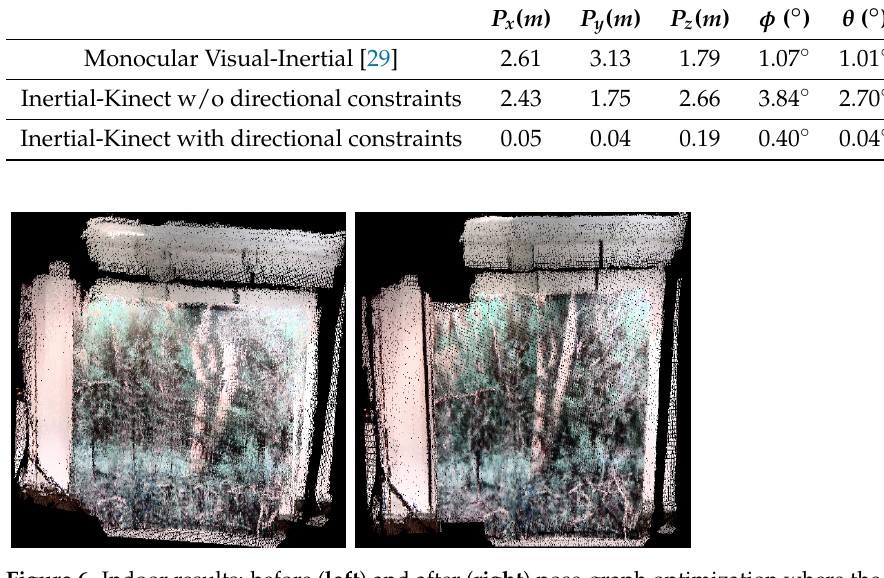
Figure 6. Indoor results: before ( left ) and after ( right ) pose-graph optimization where the room wall was textured with forest-like images.